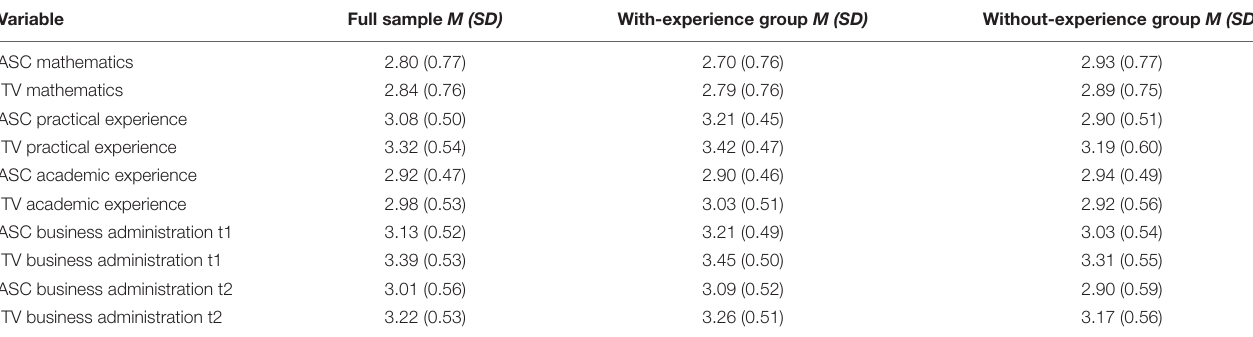
TABLE 2 | Means (M) and standard deviation (SD) of each variable for the full sample, for the without-experience group, and for the with-experience group. Variable Full sample M (SD) With-experience group M